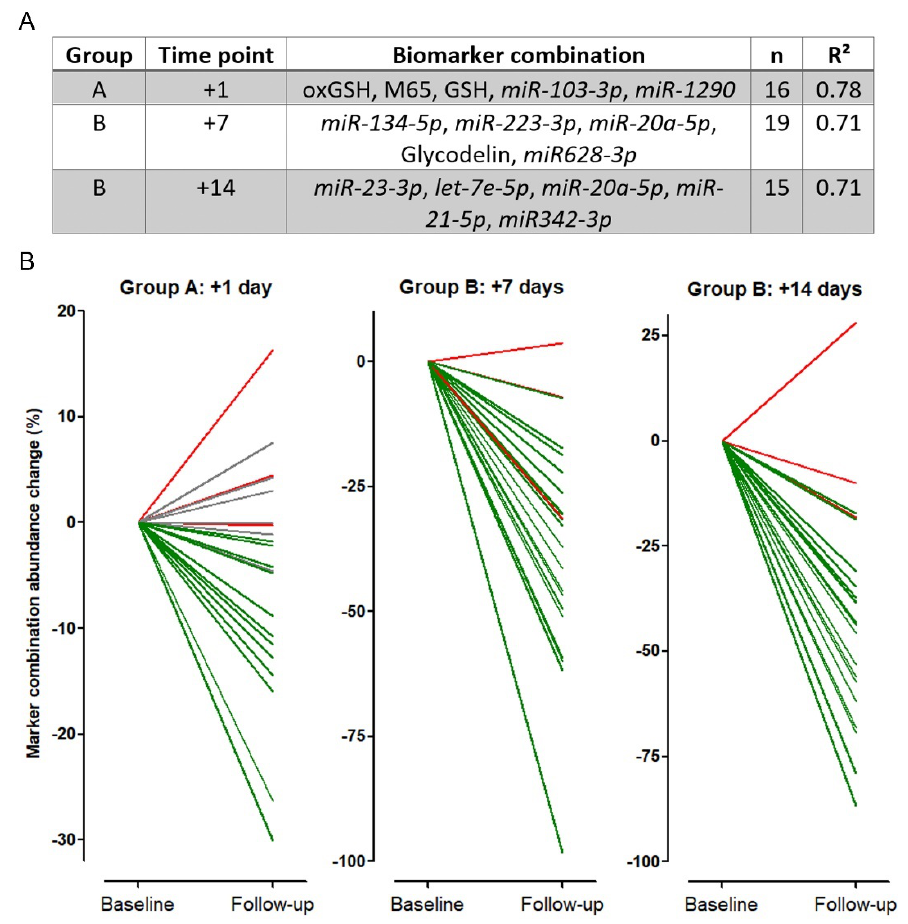
Figure 5. Stepwise regression model and marker combination abundance change. ( A ) Five-step forward regression analysis using the five best markers for each time point. ( B ) Biomarker combination from ( A ) in relation to tumor load change. Every line represents one patient. green = patients with tumor load reduction, red = patients with tumor growth, grey = patients without tumor load change at first CT scan after therapy start.